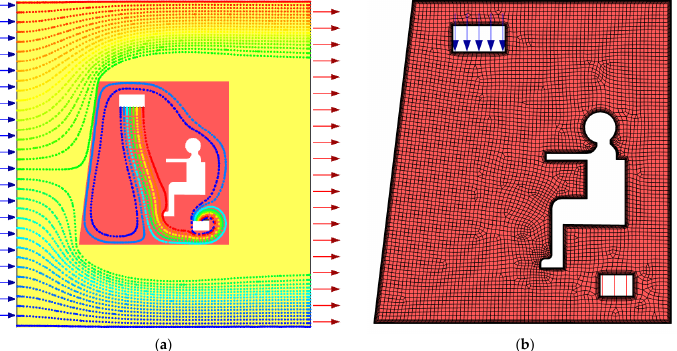
Figure 2. General scheme: ( a ) circuit inputs/outputs; ( b ) mesh of finite volumes. 3.2. Task Parameters When modeling the problem of external aerodynamics, the size of the external domain depends significantly on the airflow velocities and the temperature gradient. In this problem, the external velocity was small, and the external temperature was constant along the entire domain outside the walls; therefore, the domain size was comparable to the cabin size, which made it possible to estimate the temperature and velocity fields near the walls. The cabin wall (top, right) was a multilayer structure; according to Equations (7) and (8) and Table 1, the thermal conductivity coefficient for the walls was 0.33 W/(m ∙ K), and the thickness was 0.0312 m. Table 1. Wall parameters.